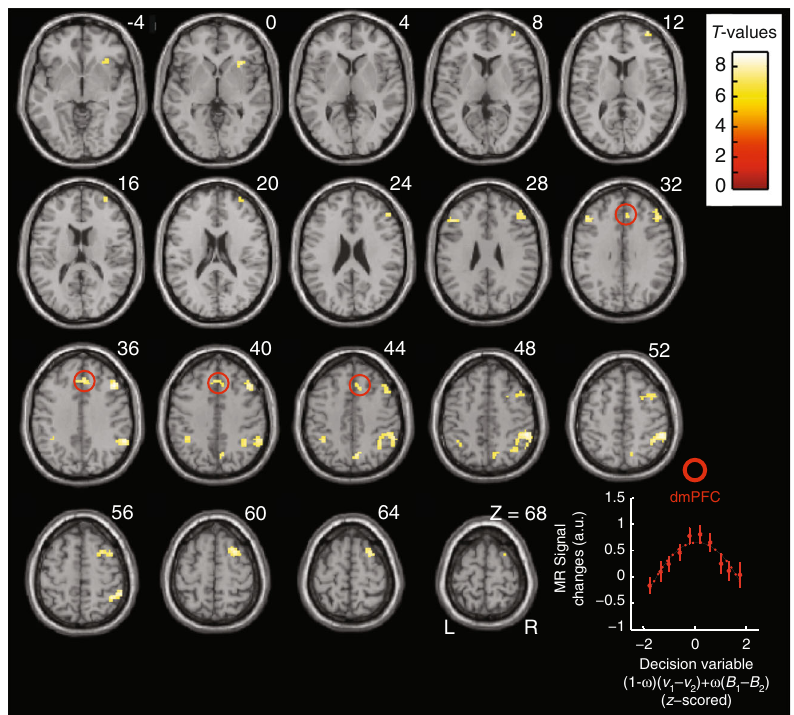
Fig. 4 Activations associated with decision entropy. Yellow, brain activations associated with an inverted U-shape function of decision variable (1 - ω ) ( v 1 – v 2 ) + ω ( B 1 – B 2 ) centred on zero from model MIX, overlaid on a canonical single-subject anatomical template (neurological convention). Axial slices are indexed by their MNI Z -coordinate. Red circles highlight dorsomedial prefrontal activations (dmPFC, Broadman ’ s area 32). Voxel-wise threshold set at p < 0.05 (T-tests) corrected for family-wise errors for multiple comparisons over the whole brain. Cluster-wise threshold p < 0.05. See Supplementary Table 3 for MNI-coordinates of activation peaks. The graph shows the actual variations of dmPFC activations according to the decision variable irrespective of reaction times (see Supplementary Fig. 3). Error bars are s.e.m. over participants ( N =